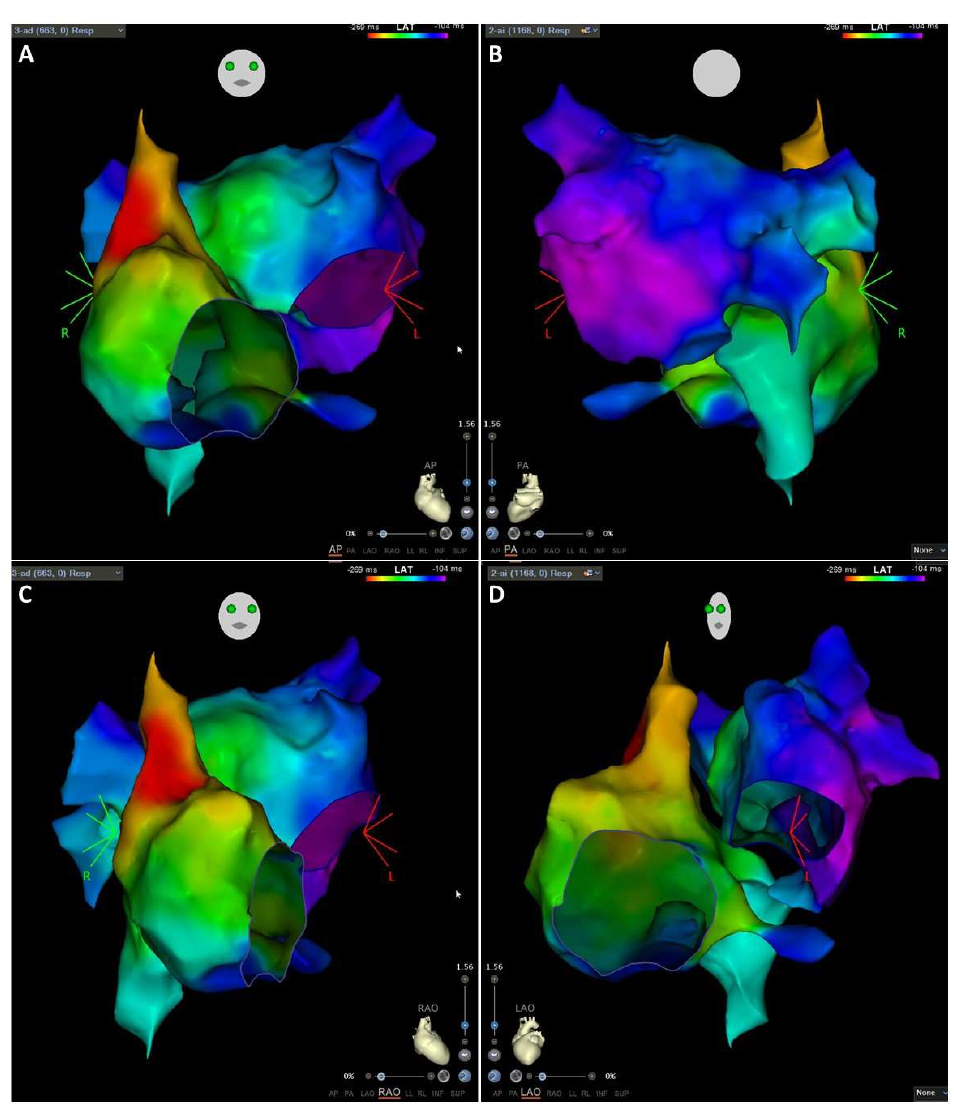
Figure 9. Electroanatomical map of a patient in normal sinus rhythm. Electroanatomical map of activation times of the right and the LA, performed during normal sinus rhythm. The atrial anatomy was determined by the magnetic catheter localization system integrated into the CARTO system. Activation sequence was derived from semi-automated sequential analysis of local electrograms. Activation times are color-coded with red indicating sites with the earliest activation and dark blue sites with the latest activations. ( A , B ): 2 images of the same map are shown in anteroposterior (AP) and posterior anterior (PA) projections, respectively. ( C , D ): 2 images of the same map are shown in right anterior oblique (RAO) and left anterior oblique (LAO) projections, respectively. Note the progressive red coding as the earliness of the mapped points increases relative to the onset of activation.